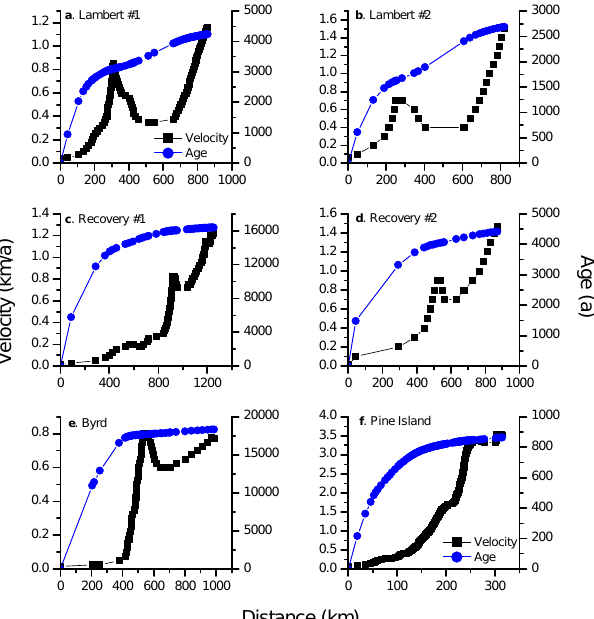
Figure 9. Plots of velocity and cumulative age with distance along uninterrupted longitudinal ice-surface structures for selected Antarctic glaciers: (a, b) Lambert Glacier, (c, d) Recovery Glacier, (e) Byrd Glacier, and (f) Pine Island